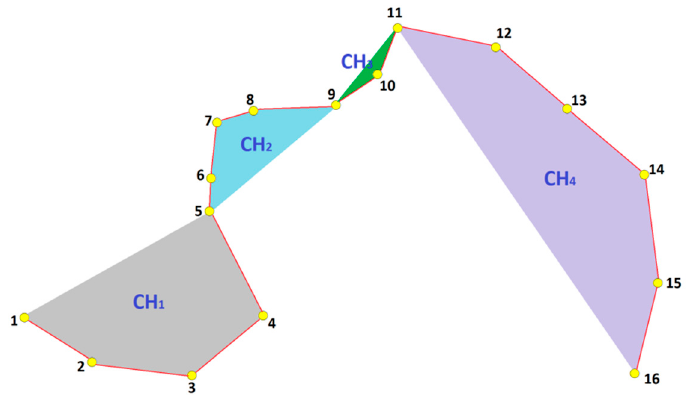
Figure 8. Convex hull structures for a given trajectory.